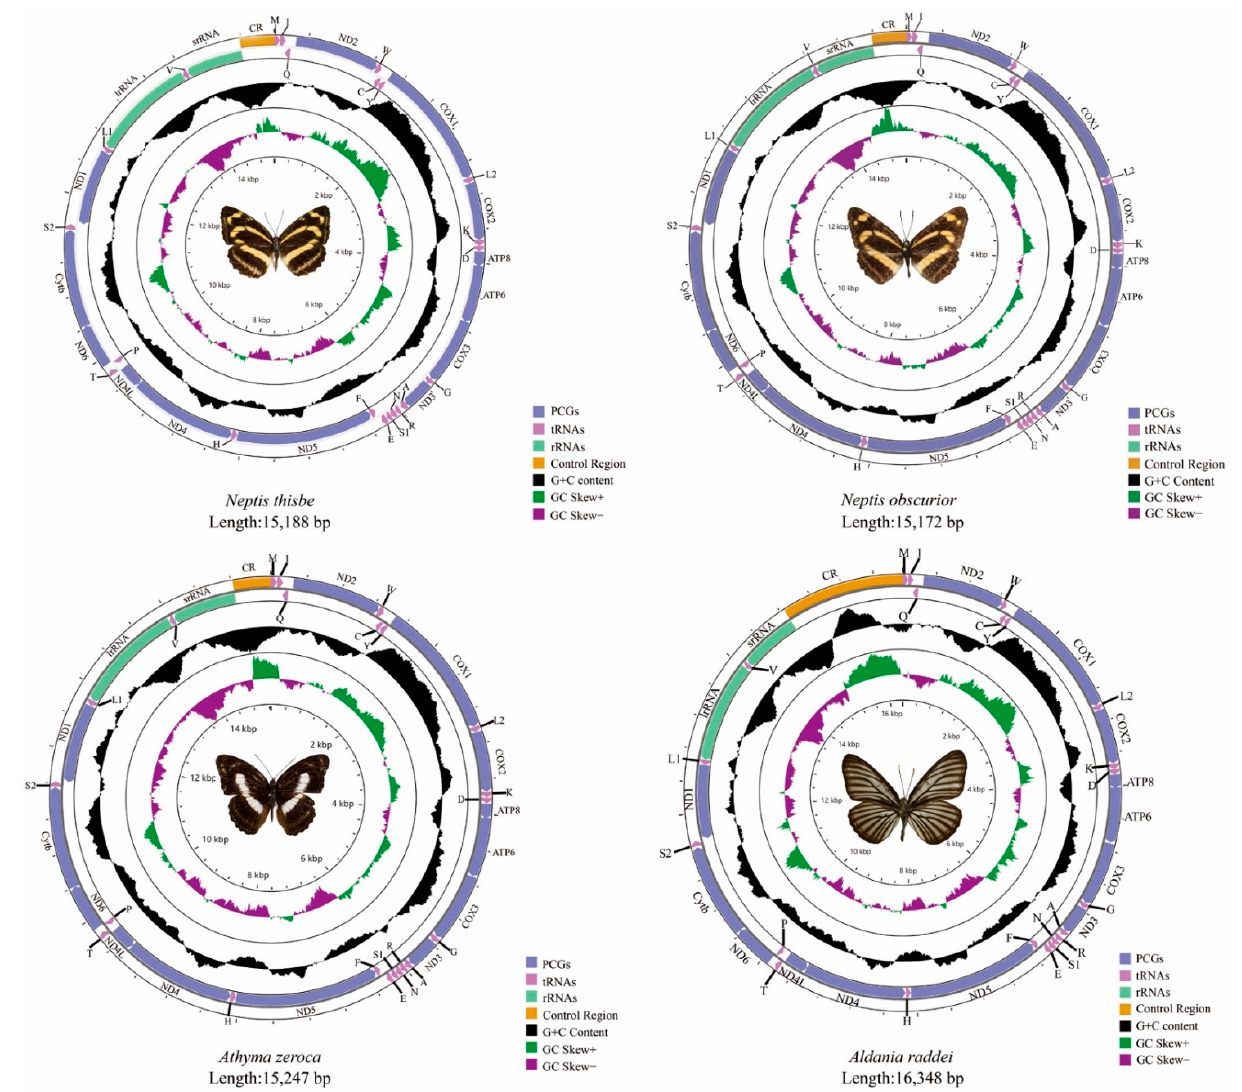
Figure 1. The mitogenomes of Neptis thisbe, Neptis obscurior, Athyma zeroca, and Aldania raddei. Each newly-sequenced mitogenome is composed of 37 genes (13 PCGs, two rRNAs and 22 tRNAs) and a non-coding A + T-control region. Among the 37 genes in these four mitogenomes, 23 genes (nine PCGs and 14 tRNAs) were located on the majority strand (J-strand) while the minority strand (N-strand) encoded another 14 genes (four PCGs, two rRNAs and eight tRNAs) (Table S2). The gene order and orientation of these four mitogenomes were identical to typical mitogenomes of Lepidoptera [21,22]. Compared to the common type that has been found in insects [23,24], the movement of tRNA Met